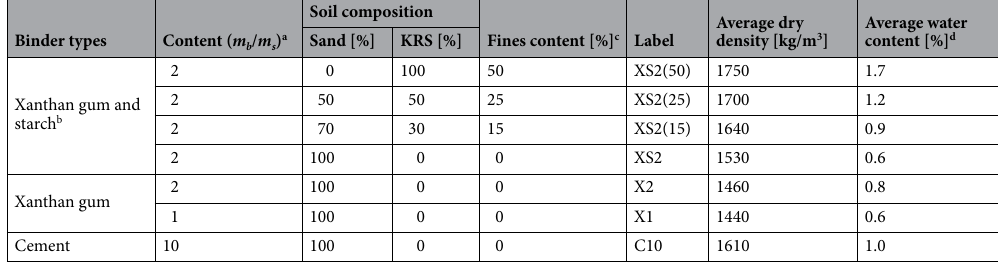
Table 2. Overview of biopolymer-treated soil preparation for durability tests. a m b / m s = ratio of binder to soil in dry mass. b Xanthan gum-starch composition is 3:7 (0.6% and 1.4%, in total 2% of m b /m s ) focusing on slope surface strengthening. c Fines content is estimated based on the particle size distribution of KRS, including 50% of fine particles (< 0.075 mm). d Average water content of specimens after 28 days of dehydration.